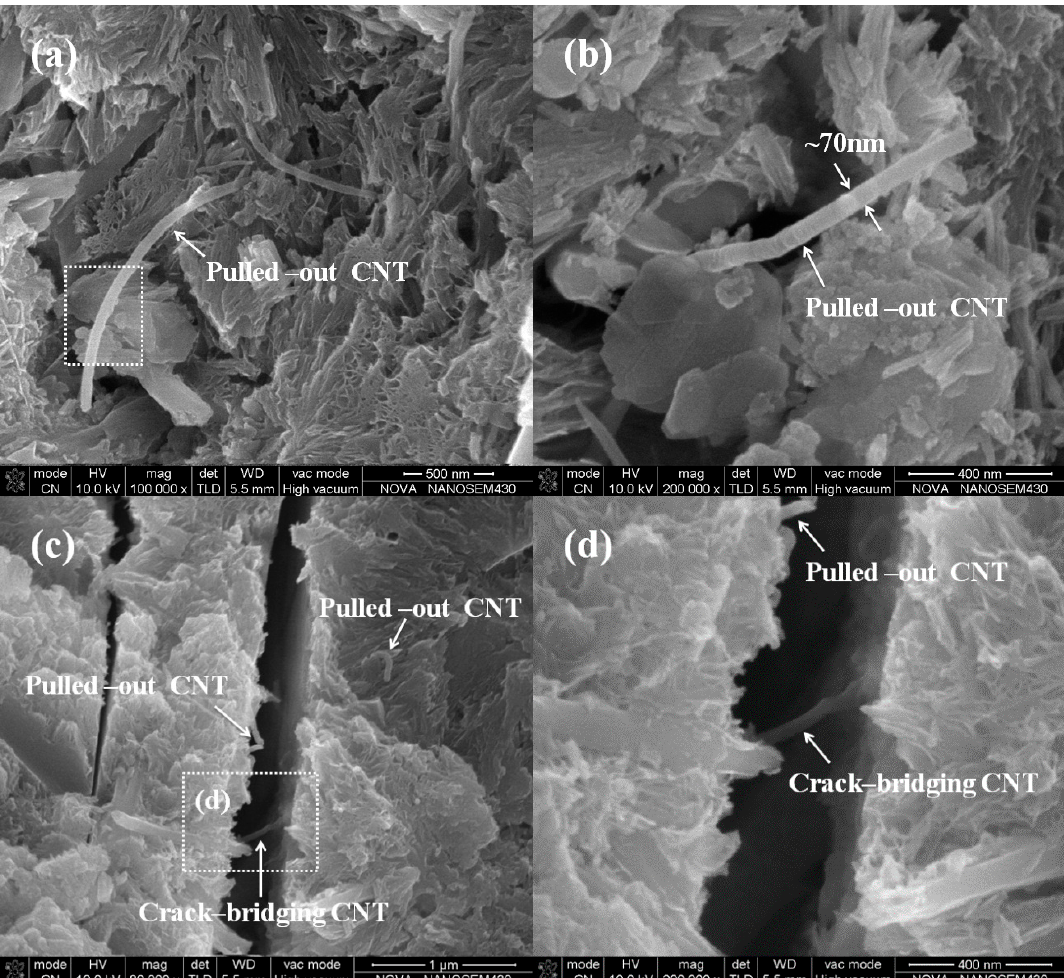
Figure 6. TEM image of MWCNTs. Bar = 200 nm.